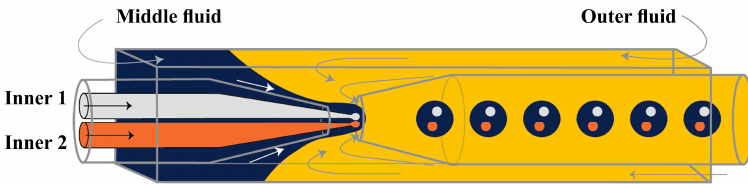
Figure 18. A glass capillary device with a double-bore injection capillary for preparation of multiple emulsion drops consisted of distinct inner drops using a single-step emulsification [78].